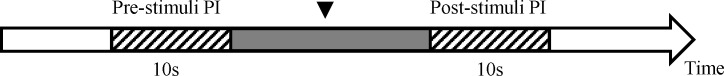
PI recording procedure for each state.Grey box, with inverted triangle above, represents a single stimulation period. The hatched boxes represent PI values recorded during 10 s periods before and after stimulation. Interval period between stimuli was 90 s. Abbreviation: Ce, effect-site concentration; PI, perfusion index; PI 1, pre-stimulus PI; PI 2, post-stimulus PI.